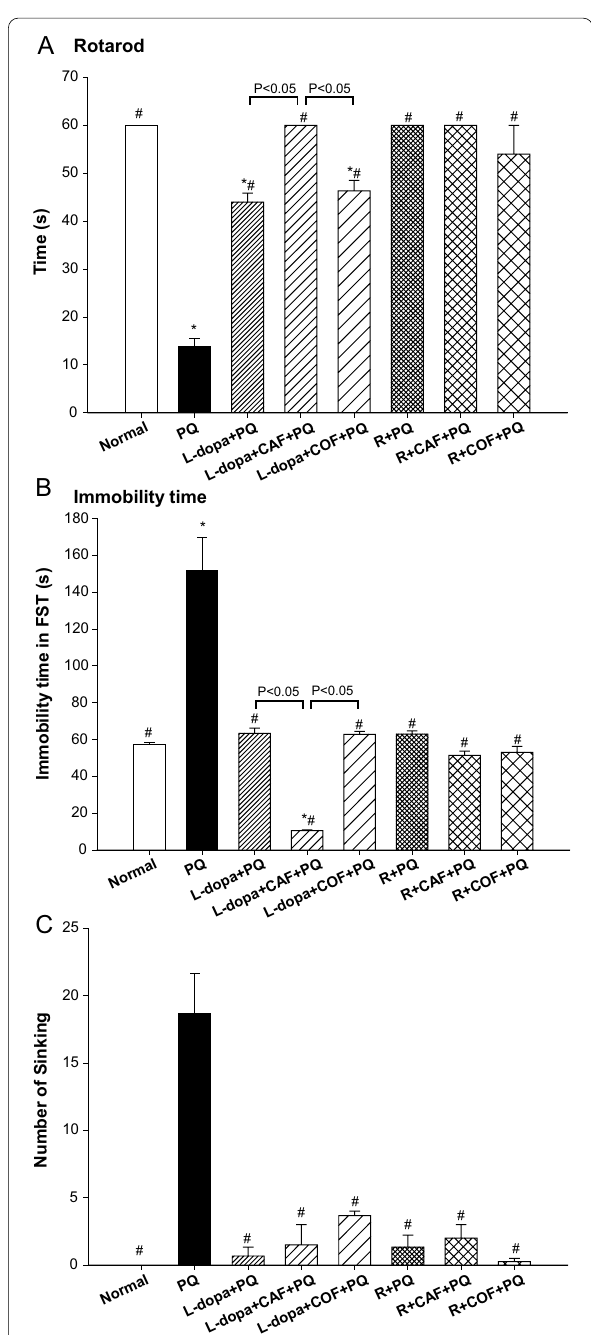
Fig. 1 Effect of each l -dopa and rasagiline (R) alone or in combination with caffeine (CAF) or coffee (COF) on behavioral activity in paraquat (PQ)-treated mice. A Rotarod test, B Immobility time in forced swim test, C Number of sinking in forced swim test. Data are presented as mean S.E.M. Differences between groups were ± statistically analyzed using a one-way analysis of variance followed by a Student–Newman–Keuls post hoc comparison. *Significant from normal group P < 0.05. # Significant from PQ group P < 0.05. Lines represent significance P <